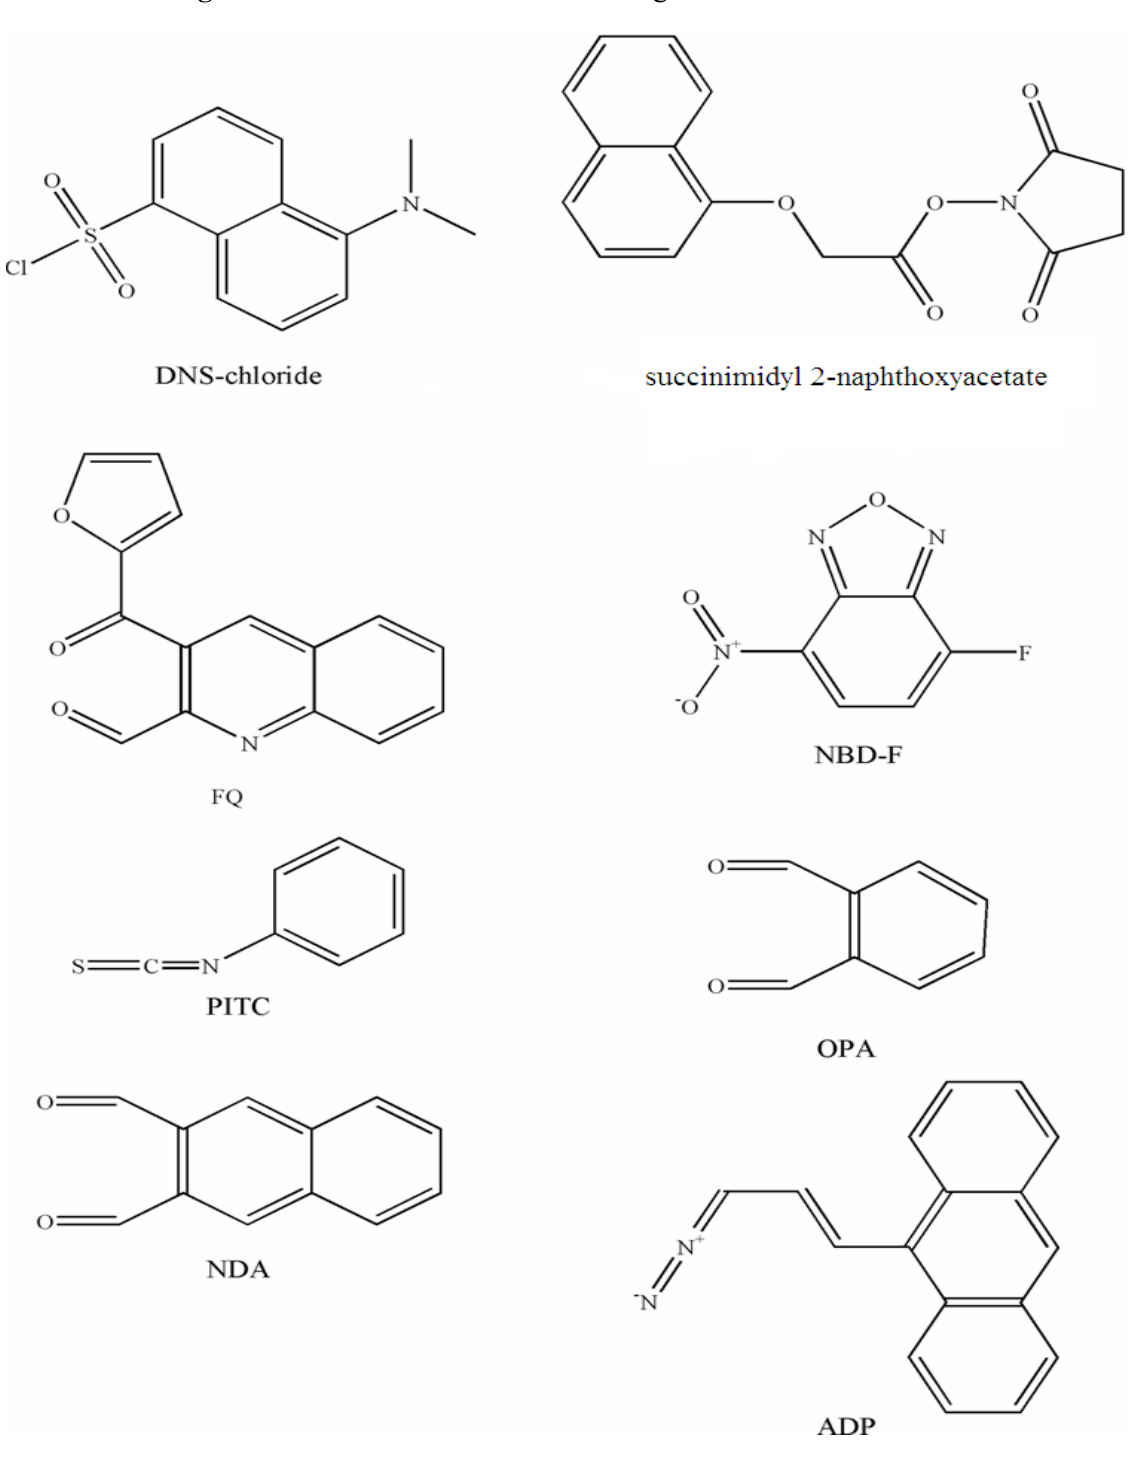
Figure 3. Chemical structures of the reagents cited in Section